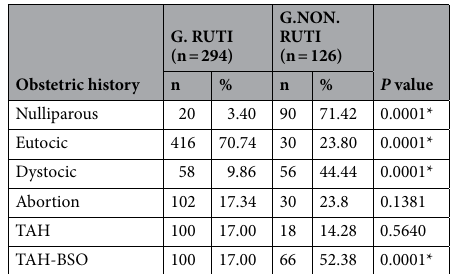
Table 1. Comparison of obstetric history and conditions between G.RUTI and G.NON.RUTI. G.RUTI: women with recurrent urinary tract infections. G.NON.RUTI: women without urinary tract infections.